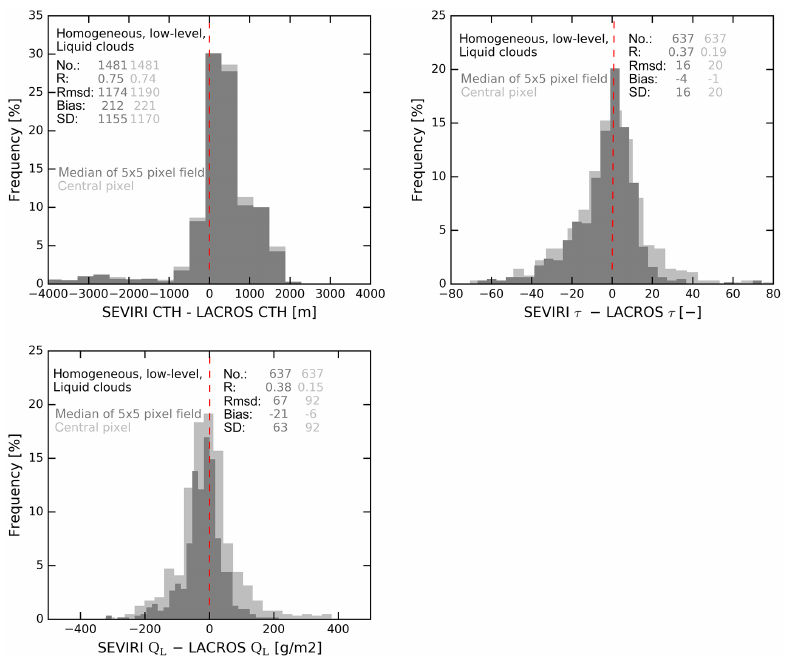
Figure 4. Histogram of differences between SEVIRI and LACROS derived cloud properties for 2012 and 2013: (a) cloud top height (CTH), (b) cloud optical depth ( τ ), (c) liquid water path ( Q L ). Median of 5 × 5 SEVIRI pixels centred at LACROS (dark gray), closest pixel to LACROS (light gray). Zero difference is marked by a dashed red line.